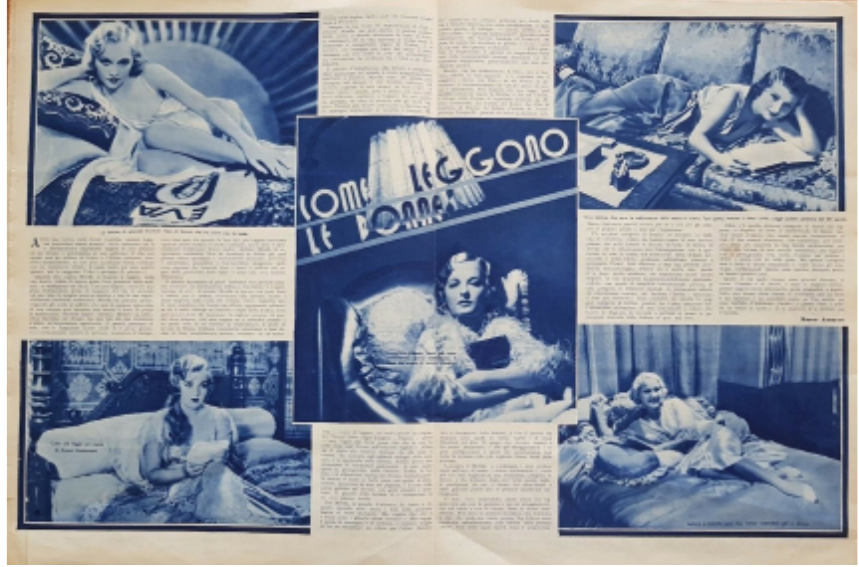
Fig. 1 ‘Come leggono le donne’, Excelsior , 8.37 (13 September 1933), no